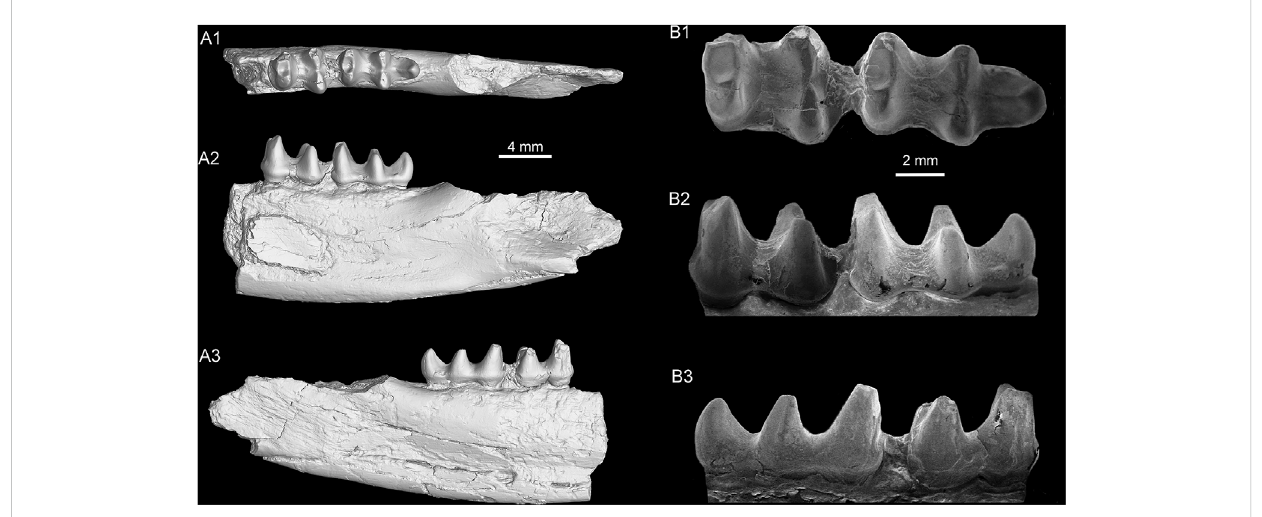
Leftlowerjawof Tapiruloidesusuensis gen.etsp.nov.withm2-3(IVPPV31737). (A1 – B1) occlusalview; (A2 – B2) ,buccalview; (A3 – B3)